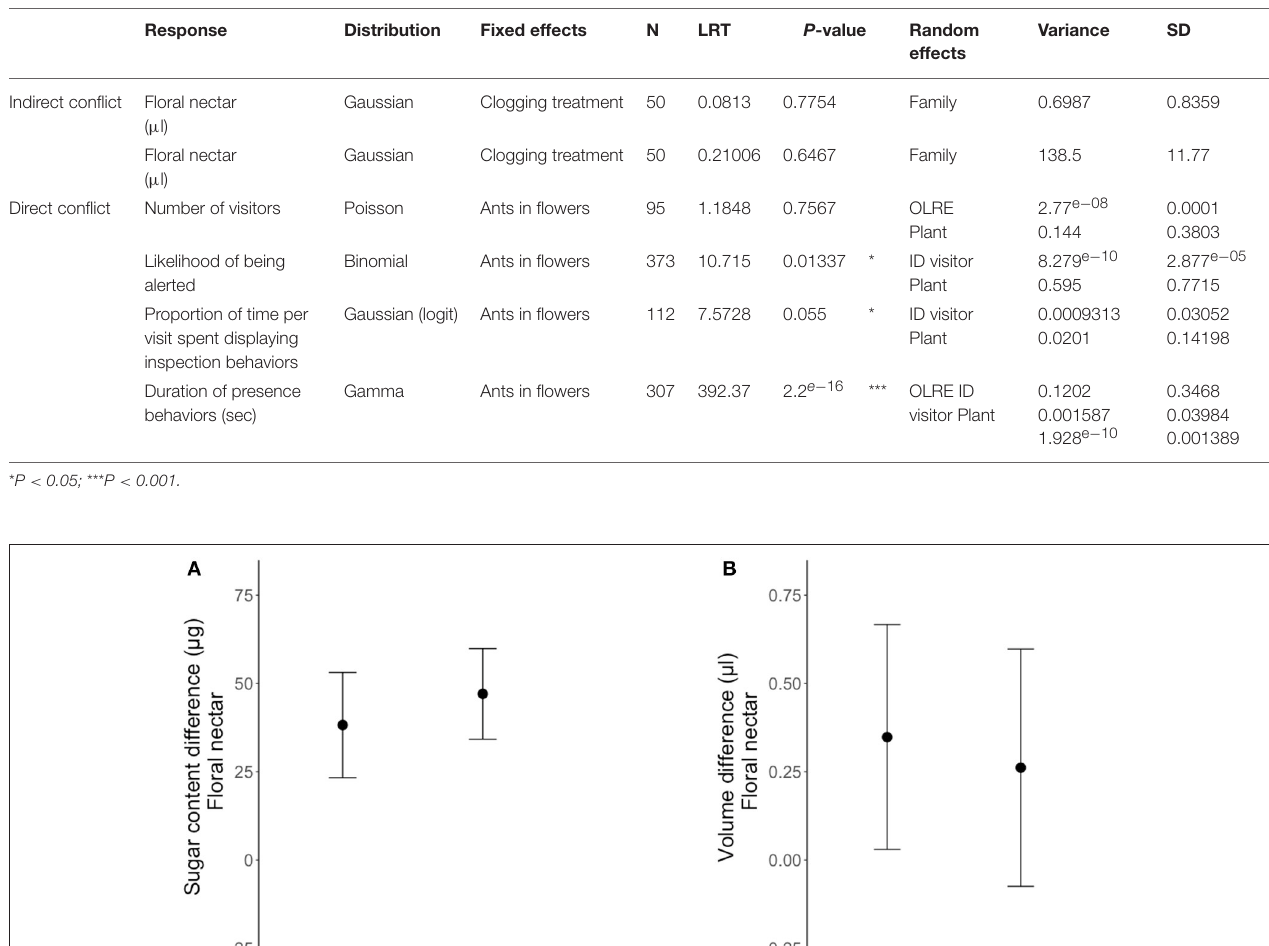
TABLE 3 | Model statistics for the experiments testing indirect (nectar-mediated) and direct (pollinator deterrence) ant-pollinator conflict.